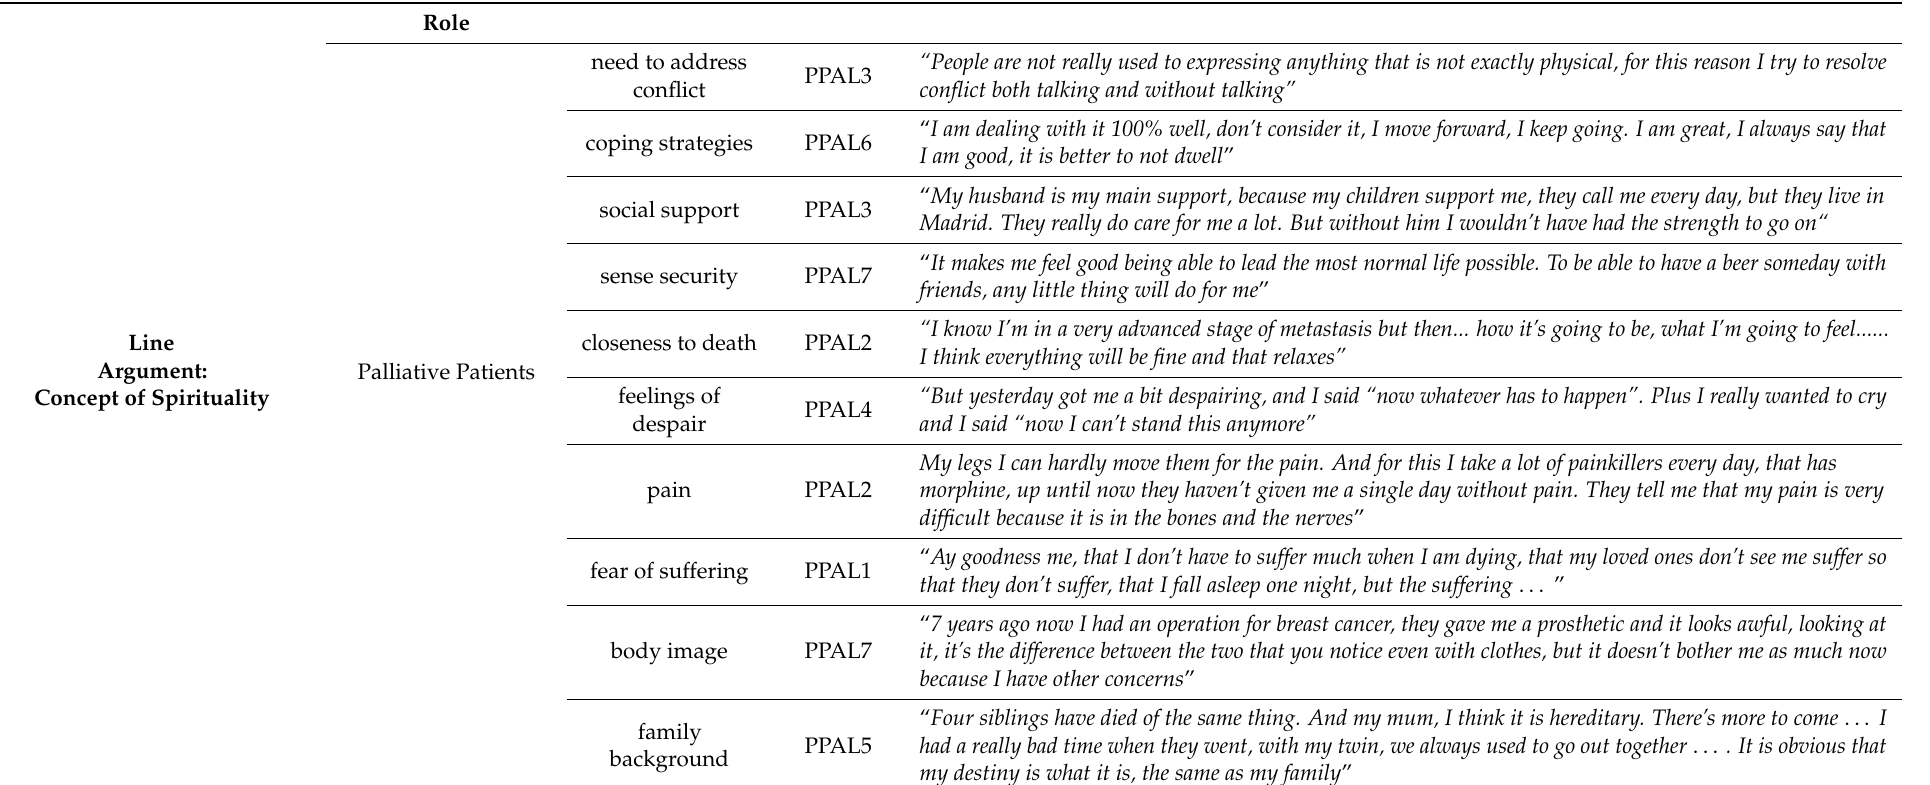
Table 5. Line of argument 3, palliative patient group. Factors that influence patient spirituality at the end of